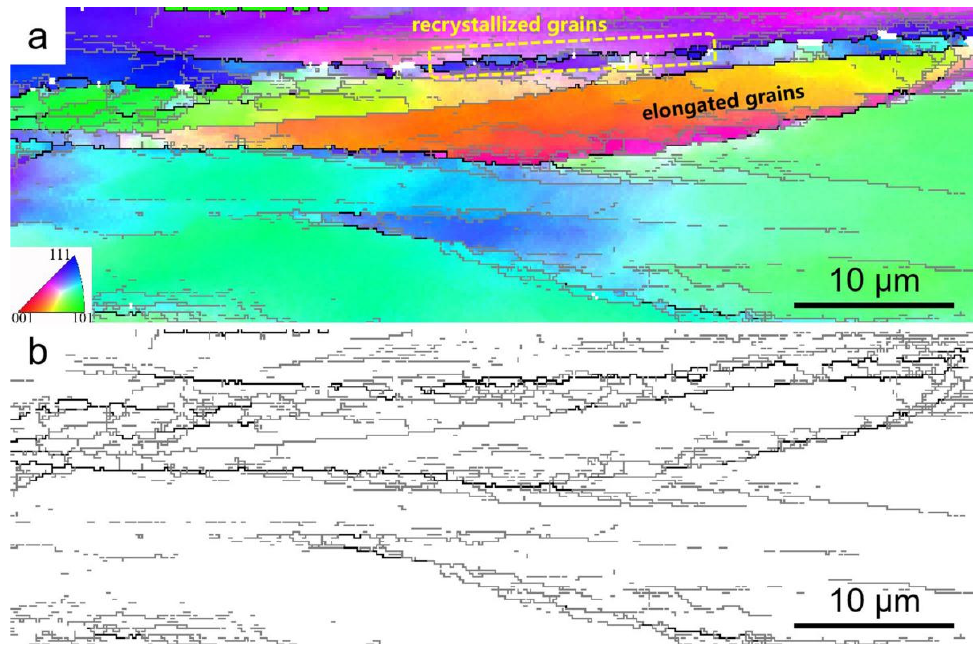
Figure 5. EBSD images of hot-compressed microstructures of Ti-B12 alloy at a true strain of 0.8: ( a ) IPF figure; ( b ) grain boundary distribution mapping.